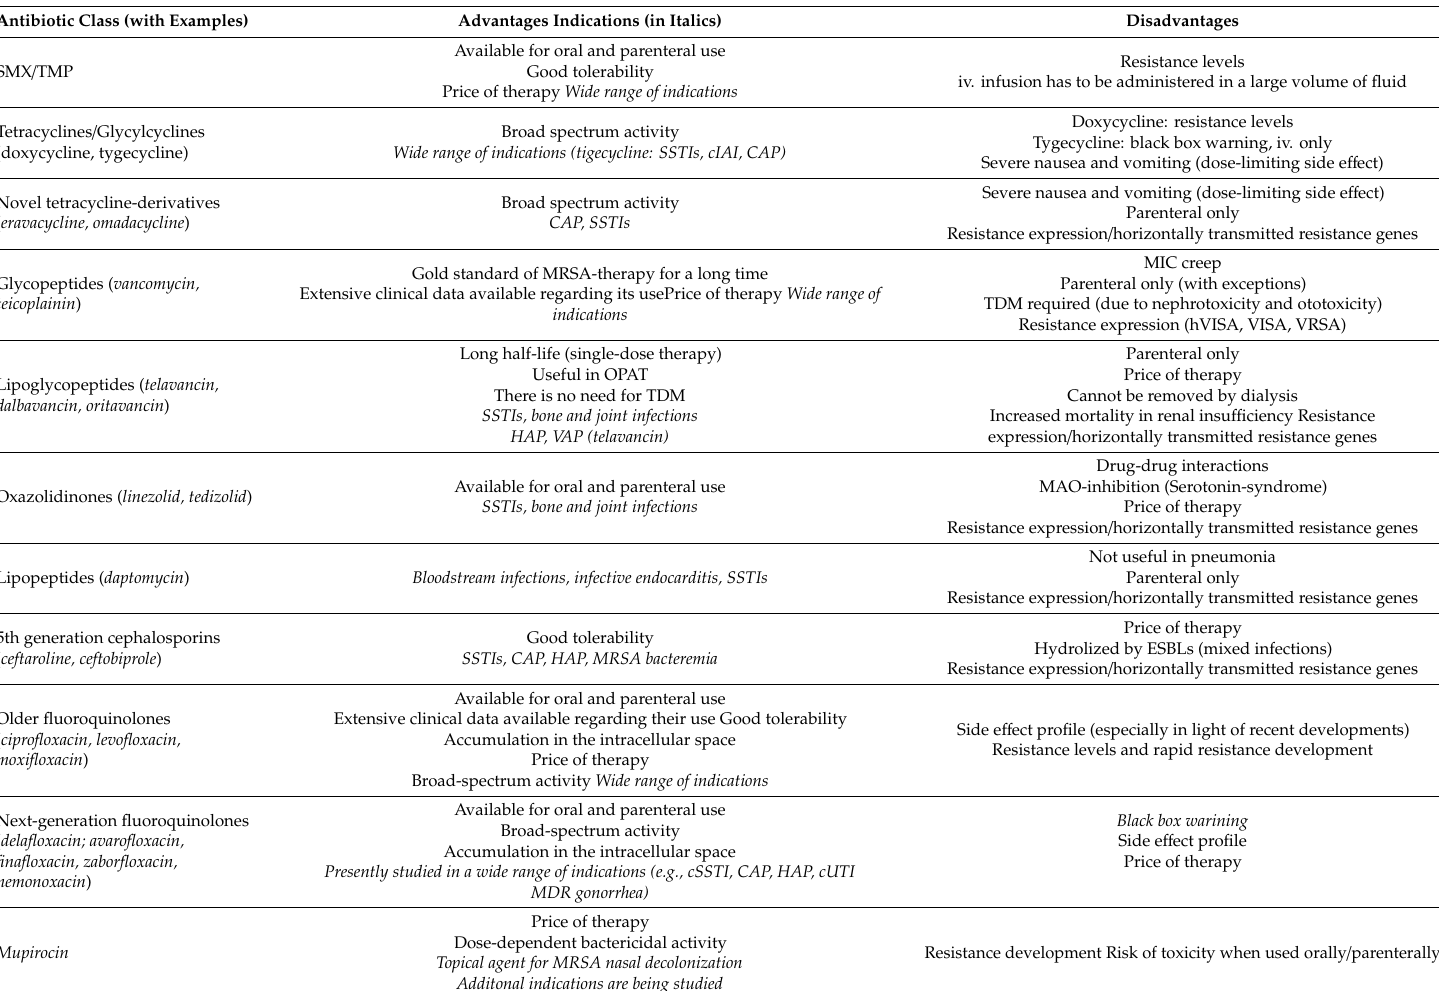
Table 1. Summary of advantages and disadvantages for various drug classes involved in the treatment of MRSA infections